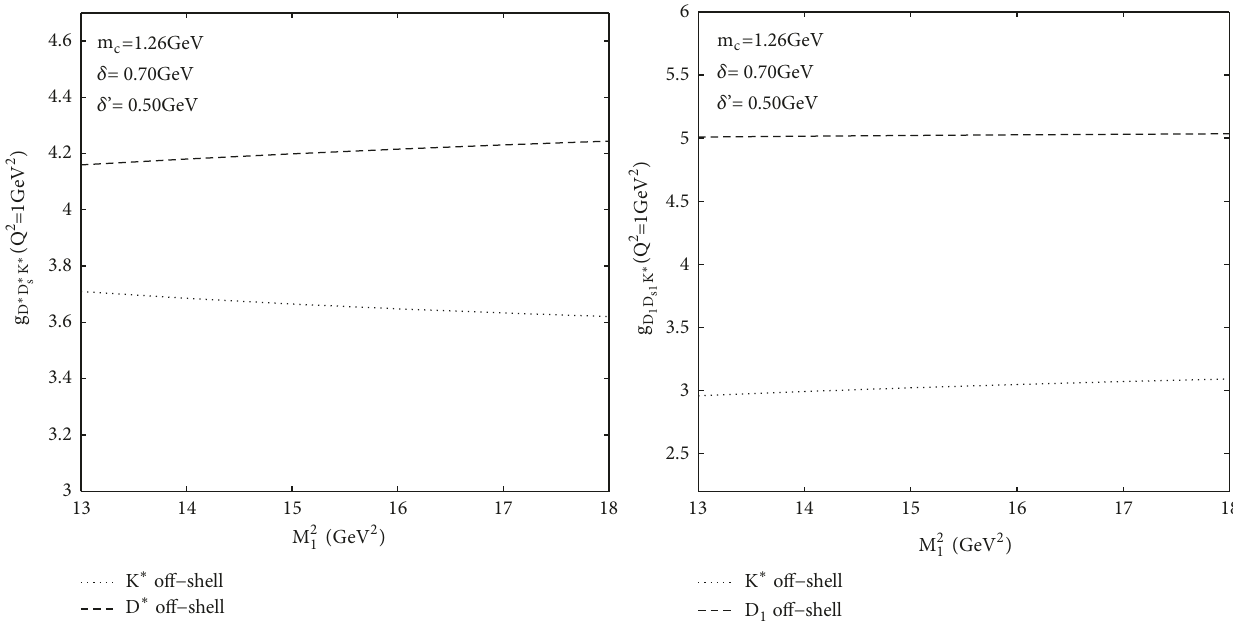
Figure 4: The strong form factors 𝑔 퐷 ∗ K ∗ mesons.